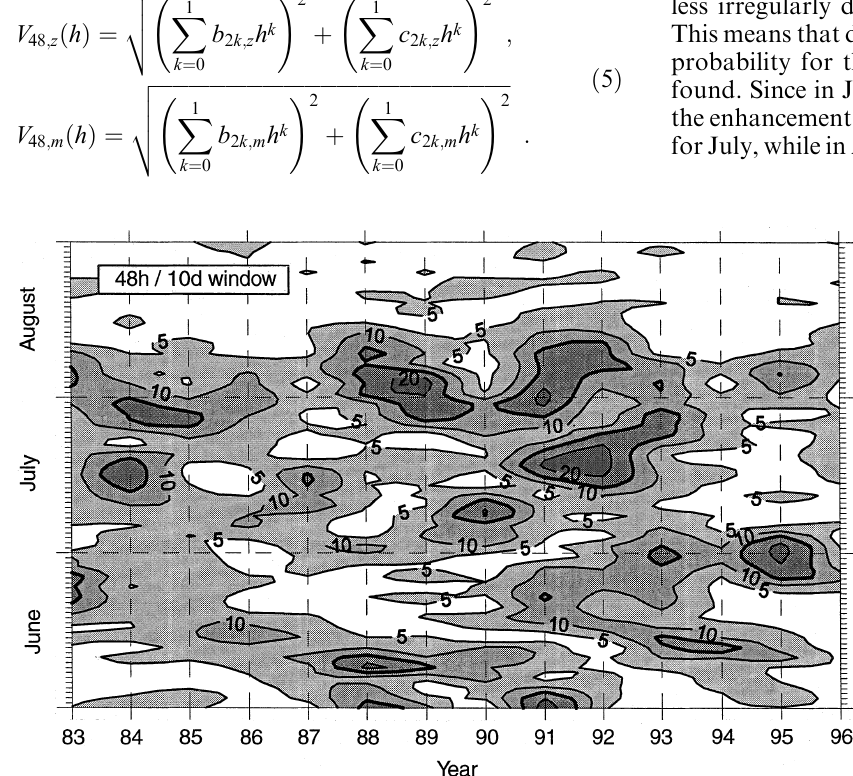
of the 2-day 48, z